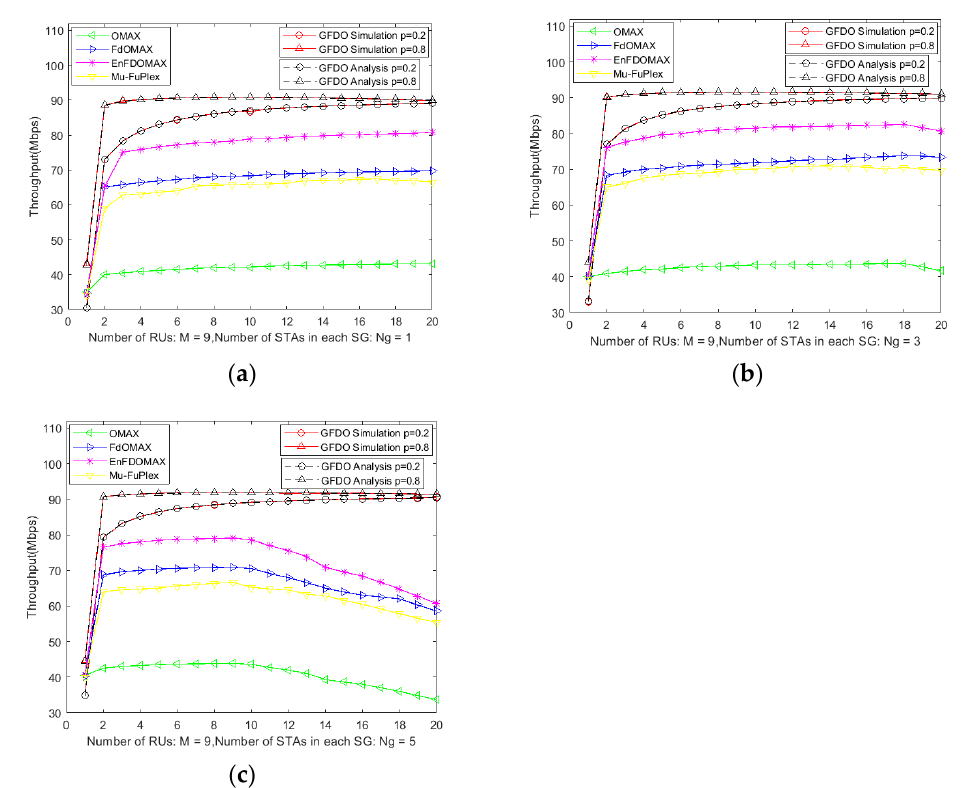
Figure 5. Analysis of system throughput under di ff erent P -probability. ( a ) Throughput vs. Number of STAs in each SG is 1; ( b ) Throughput vs. Number of STAs in each SG is 3; ( c ) Throughput vs. Number of STAs in each SG is 5.